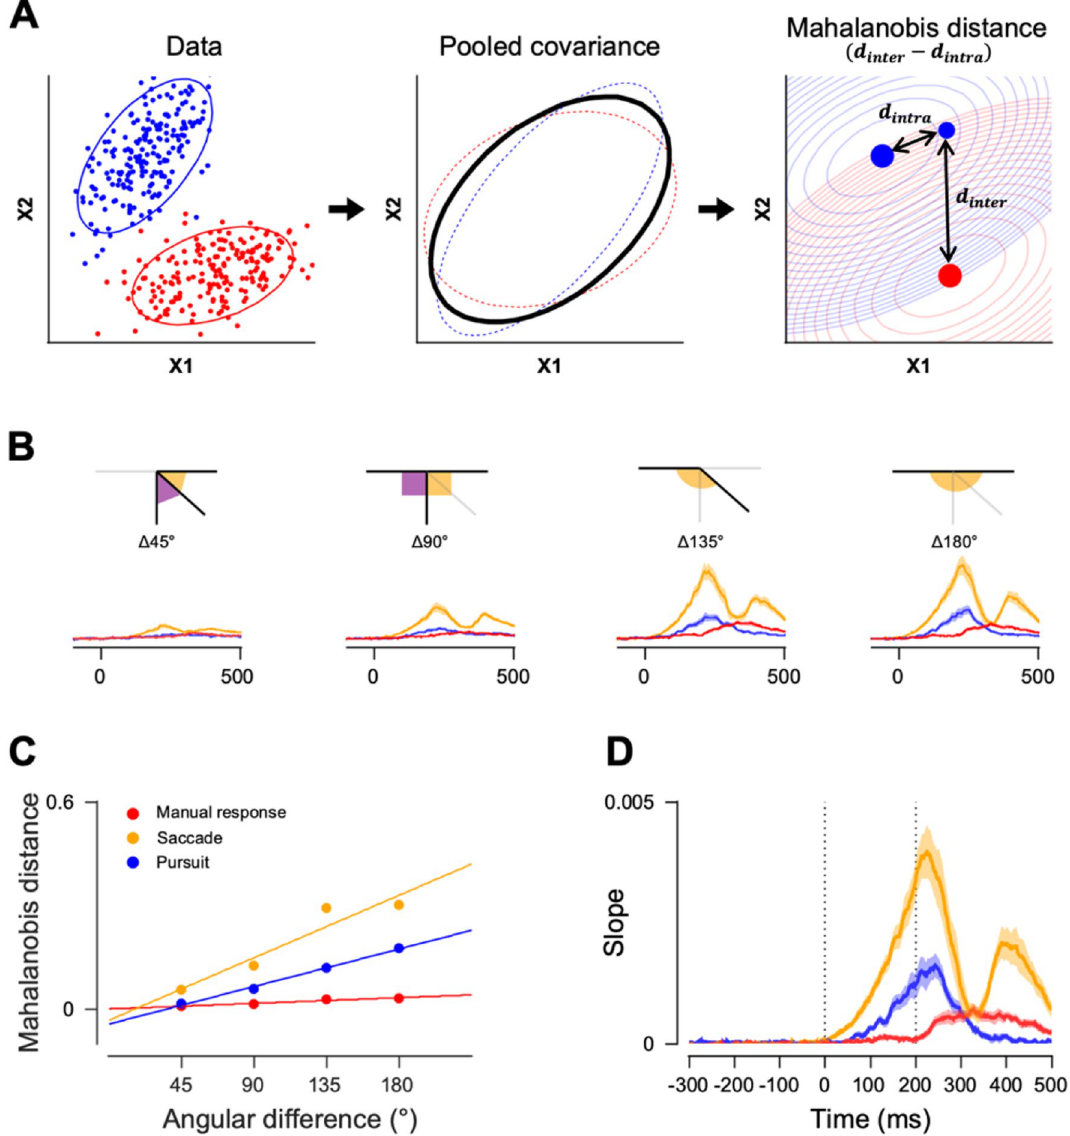
Figure 2. The schematic diagram for Mahalanobis distance calculation and the neural direction discrimination analysis. ( A ) Procedure for calculating dissimilarity between the two multivariate measurements. The inter-group distances were compared with intra-group distances and they were normalized by the pooled covariance. ×1 and ×2 represent two dimensions of example data, shown for illustration purposes. Each contour in the rightmost plot is an equal distance line. ( B ) Mahalanobis distances of the multivariate EEG activity pattern for each angular difference group (45°, 90°, 135°, or 180°), in each effector behavior condition (red: manual response, yellow: saccade, and blue: pursuit). ( C ) The linear regression coefficient of the relationship between the angular differences on the x-axis and corresponding Mahalanobis distances on the y-axis was calculated at each time point. ( D ) Regression slopes are plotted as a function of time for each effector behavior condition. The line and shaded area indicate mean and standard error across participants,